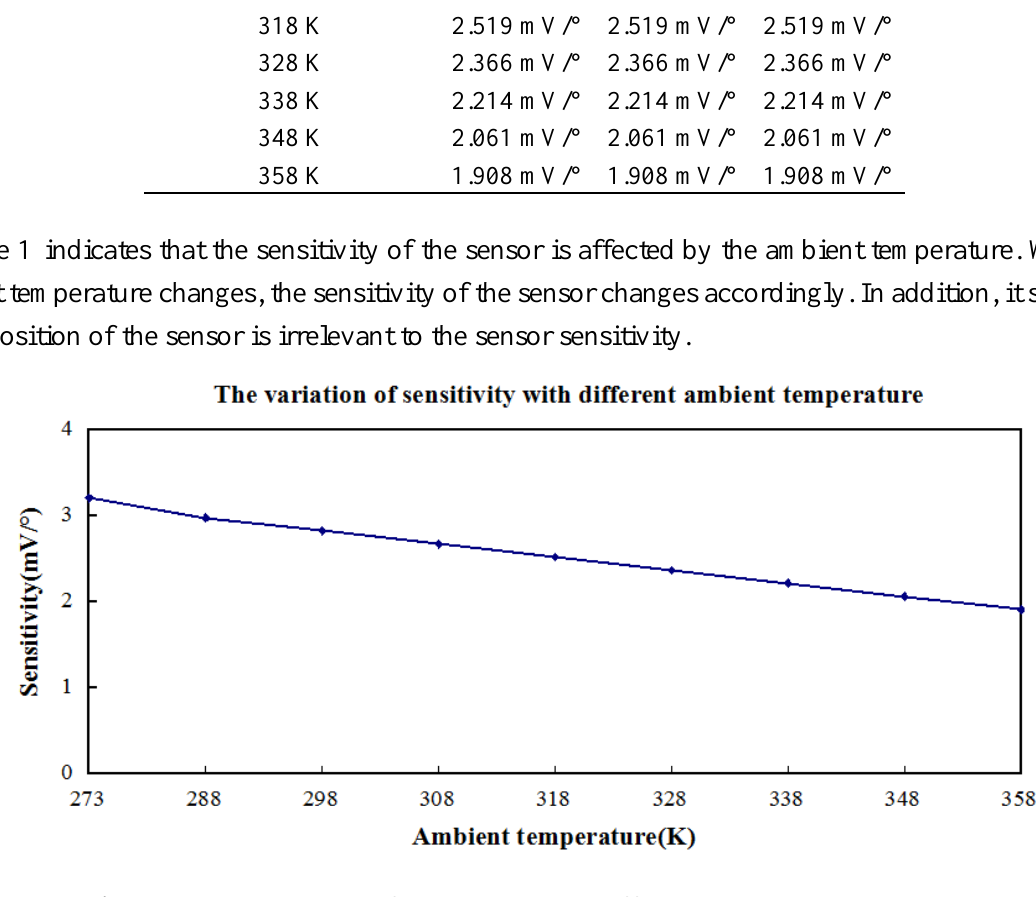
Figure 8. The variation of sensitivity with different ambient